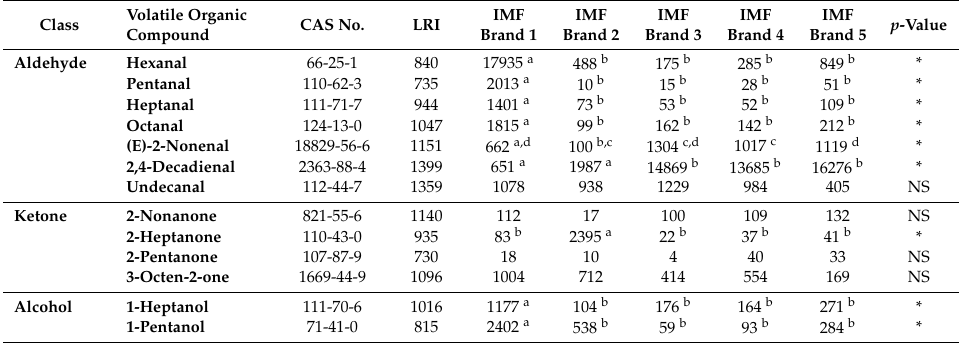
Table 6. Concentrations (mg / kg of powder; n = 3) of the 13 volatile compounds quantified in the five infant milk formula (IMF) powder samples (Brands 1-5) purchased from local retail units. Di ff erent superscripts within a row indicate statistical di ff erences when p =